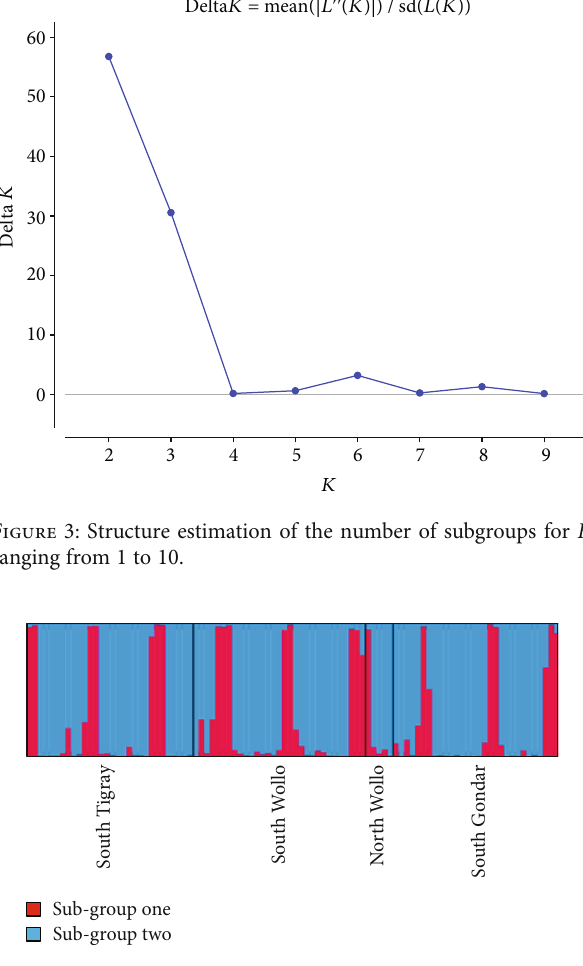
Figure 4: This fi gure shows the genetic assignment of individuals to populations inferred from structure analysis at K = 2 based on SSR markers.